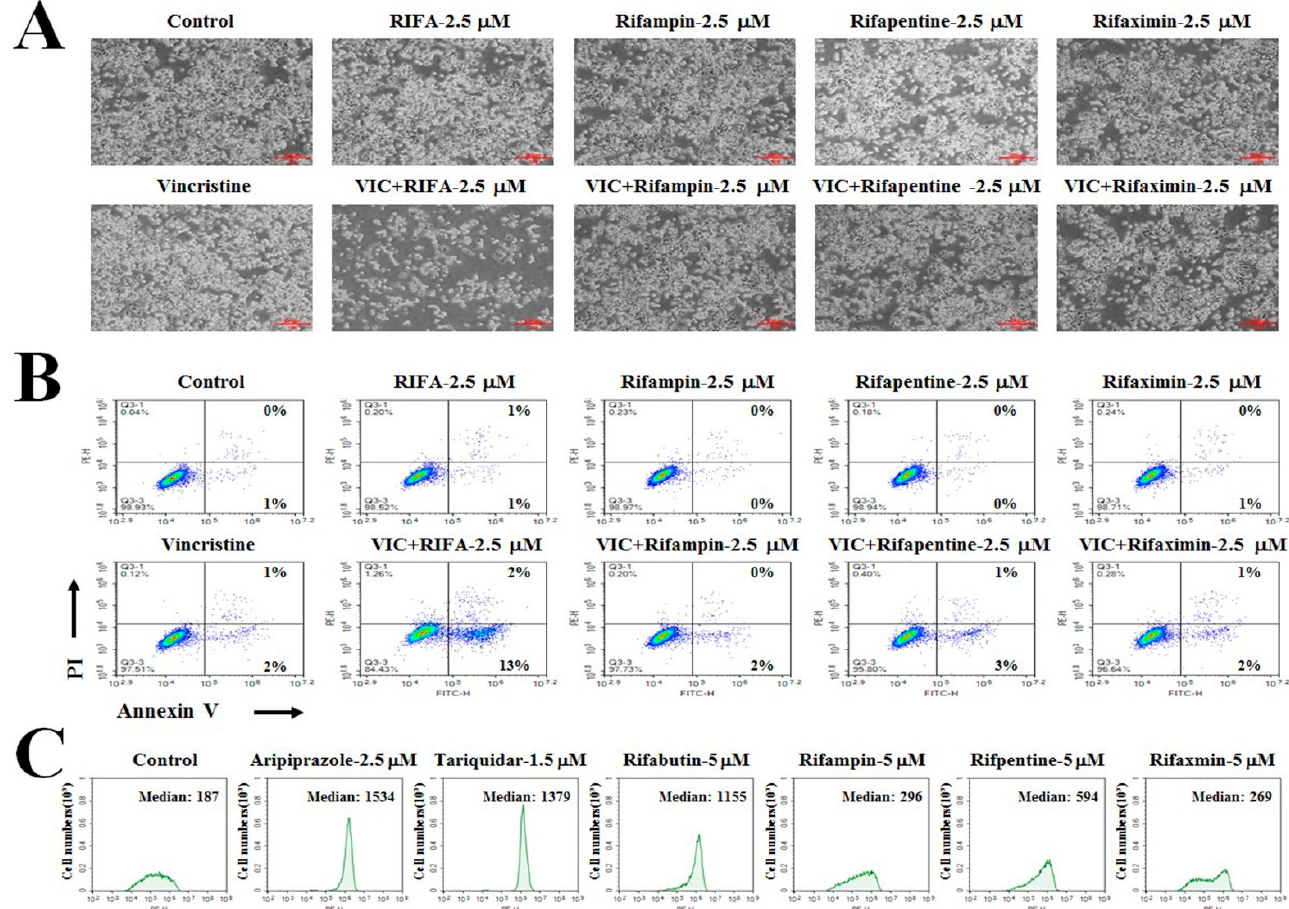
Figure 5. Other tuberculosis drugs (rifampin, rifapentine, and rifaximin) have little P-gp-inhibitory activity. ( A , B ) KBV20C cells were treated with 2.5 μ M of rifabutin (RIFA), rifampin, rifapentine, and rifaximin alone or in combination with 5 nM VIC, or 0.1% DMSO (Control). After 24 h, all cells were observed using an inverted microscope at × 40 magnification ( A ) or subjected to annexin V analyses ( B ). ( C ) KBV20C cells were treated with indicated concentrations of aripiprazole, tariquidar, rifabutin (RIFA), rifampin, rifapentine, rifaximin, or 0.1% DMSO (Control). After 1 h, all cells were stained with rhodamine123 for 3 h and examined using FACS